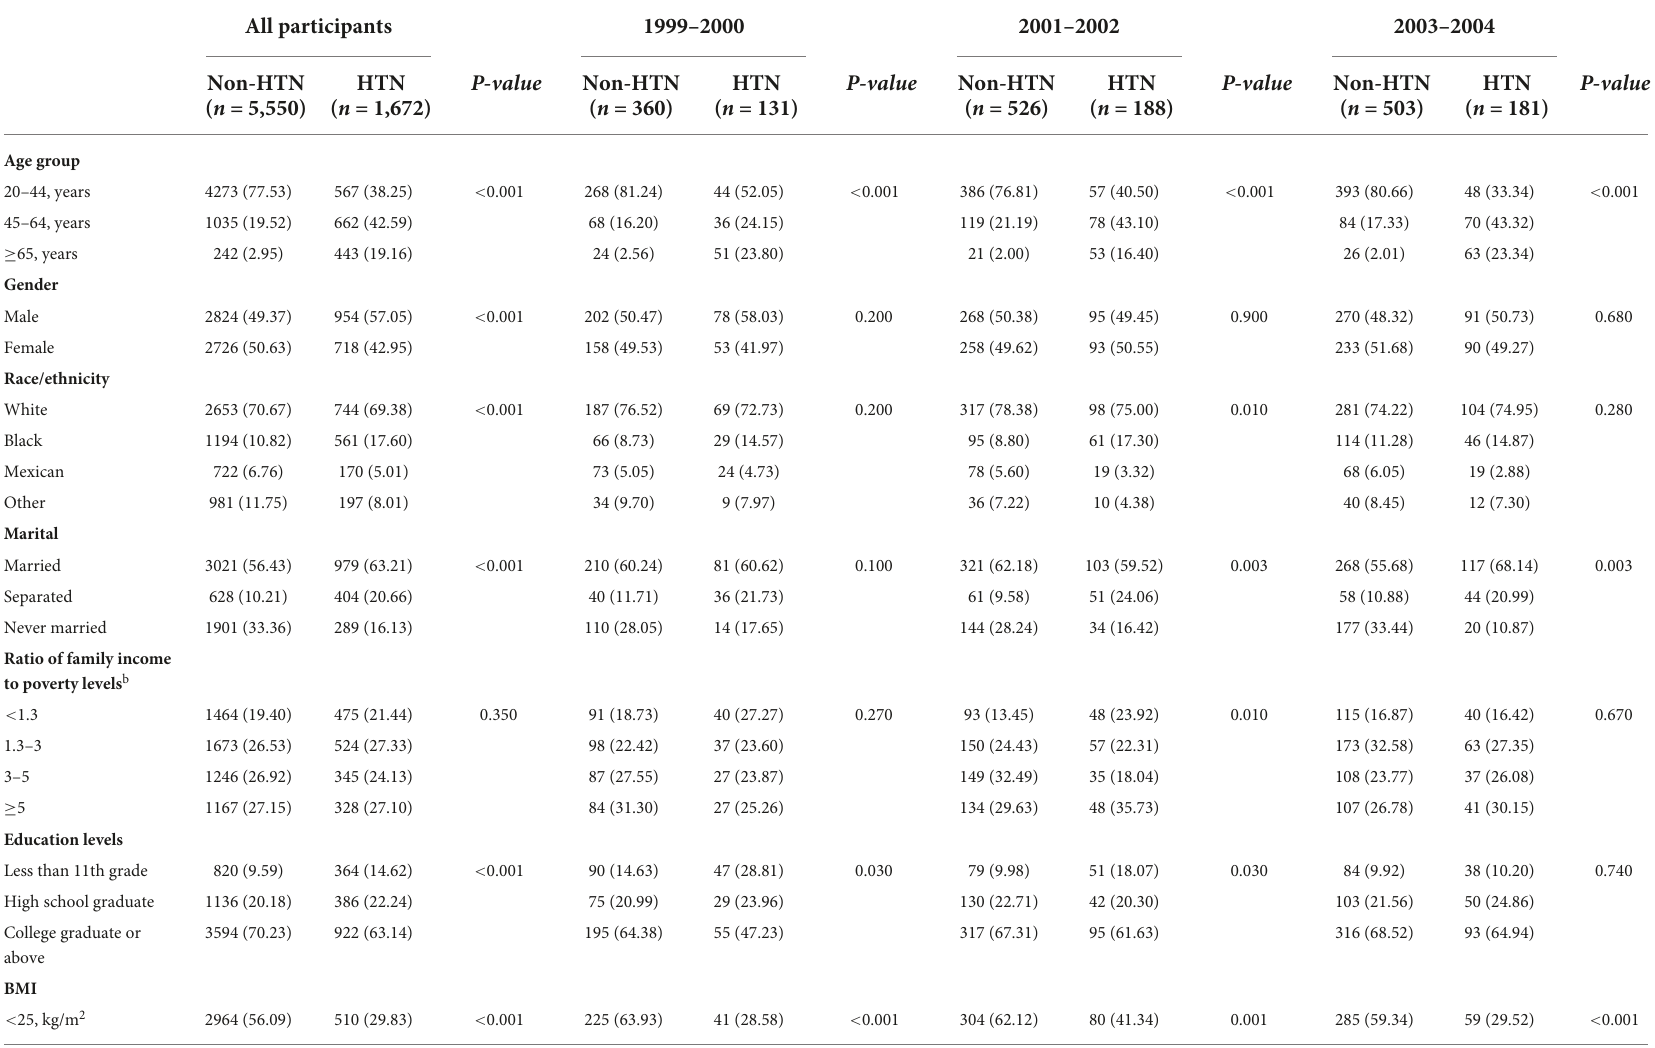
TABLE 1 Socio-demographic characteristics of US adults with hypertension by NHANES survey cycle, 1999–2018 ( N =